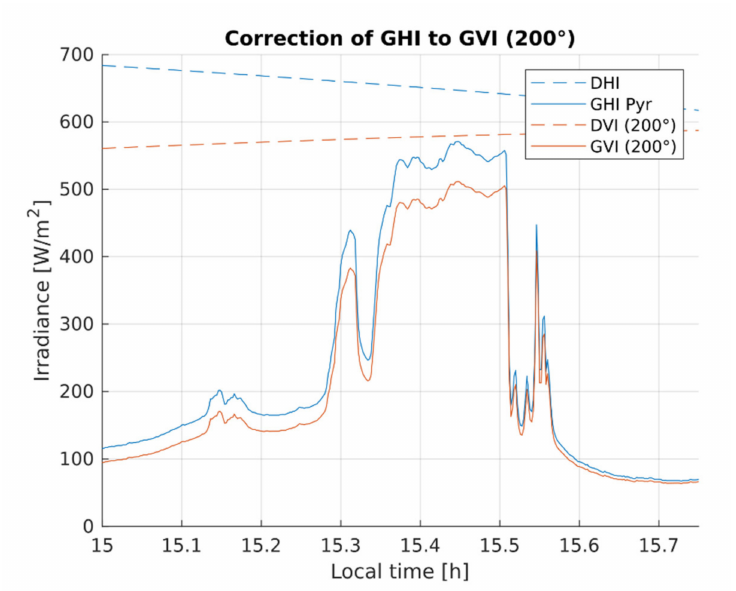
Figure 2. Correction of GHI to GVI as before, zoomed in to show the relevant part of the dataset containing step